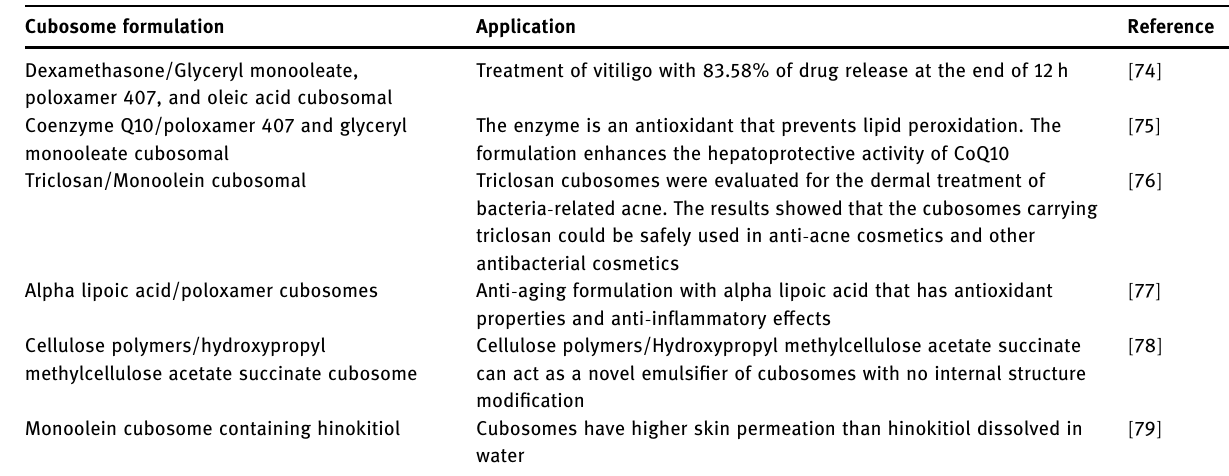
Table 2: Applications of cubosome formulations Cubosome formulation